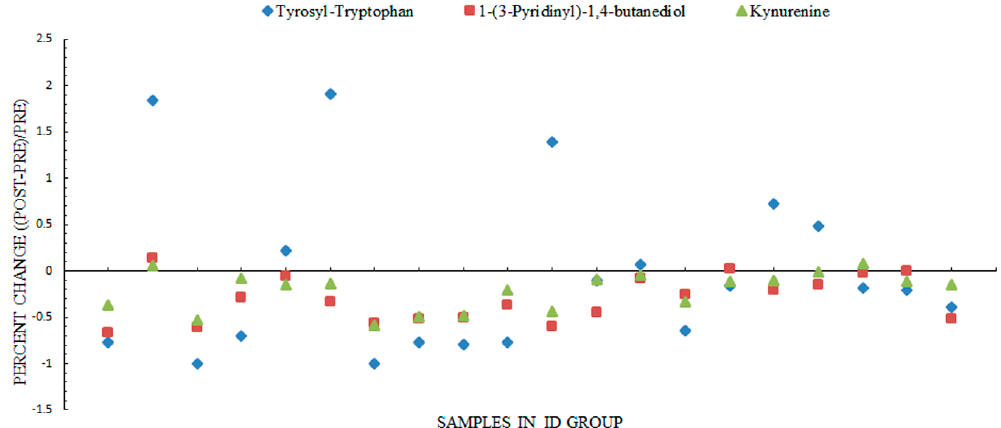
Figure 4. Percent change of the three differential metabolites at post-intervention compared to pre-intervention for each child from the ID group. Blue, tyrosyl-tryptophan; red, 1-(3-pyridinyl)-1,4-butanediol; green, kynurenine; and ID, concentration of nicotine in children’s urine was decreased after the smoking-cessation intervention for smokers, which is called the intervention-declined group (ID) for short.